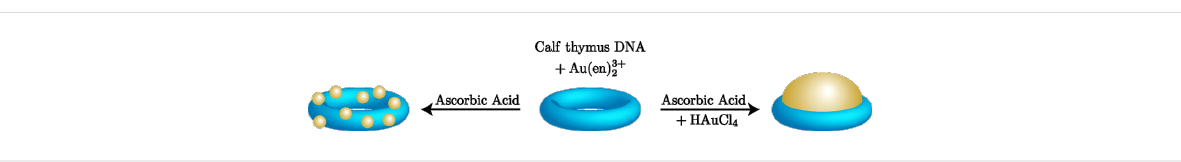
Figure 6: Products obtained when gold(III) is reduced in the presence of DNA toroids formed with bis(ethylenediamine)gold(III). Reprinted with permission from [66]. Copyright 2010 American Chemical